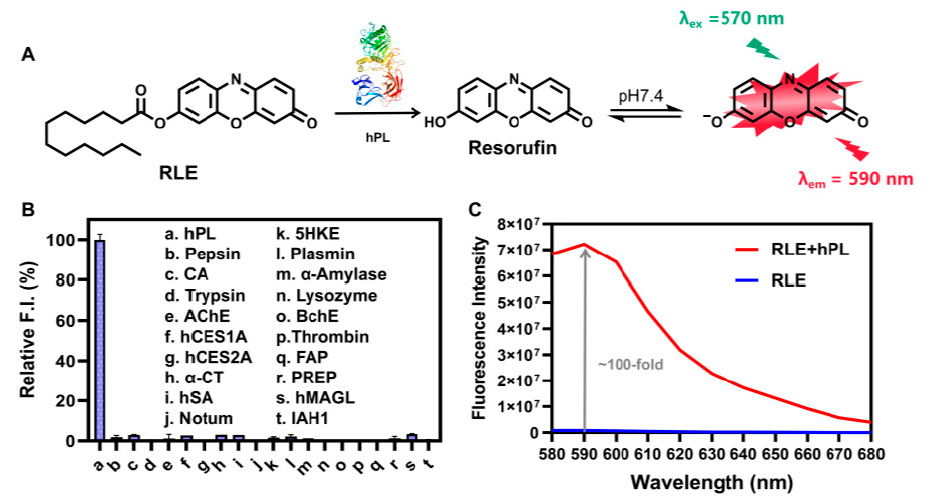
Figure 2. ( A ) Proposed sensing mechanism of the hPL-triggered RLE fluorescence response. ( B ) Fluorescence response intensity of RLE with various hydrolase incorporations. ( C ) Fluorescence emission spectra of RLE (5 µM) in the presence and absence of hPL; λ em = 590 nm. All data are expressed as mean ± SD.